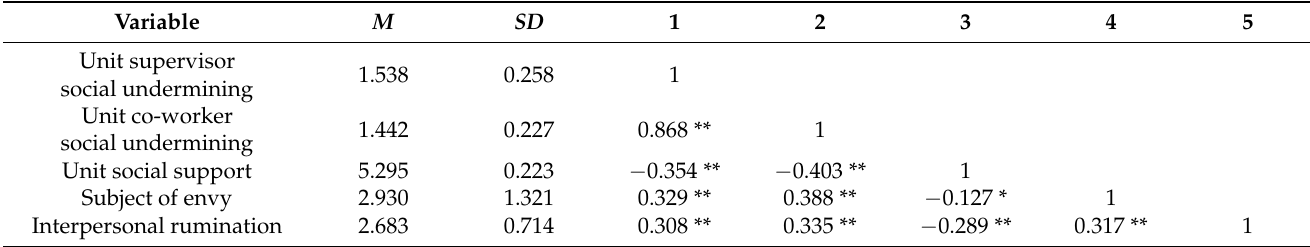
Table 2. Means, standard deviations, and intercorrelations of continuous